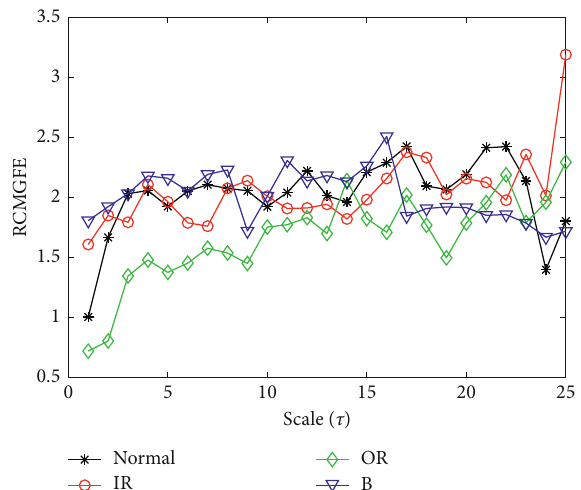
Figure 4: RCMGFE corresponding to each status signal.